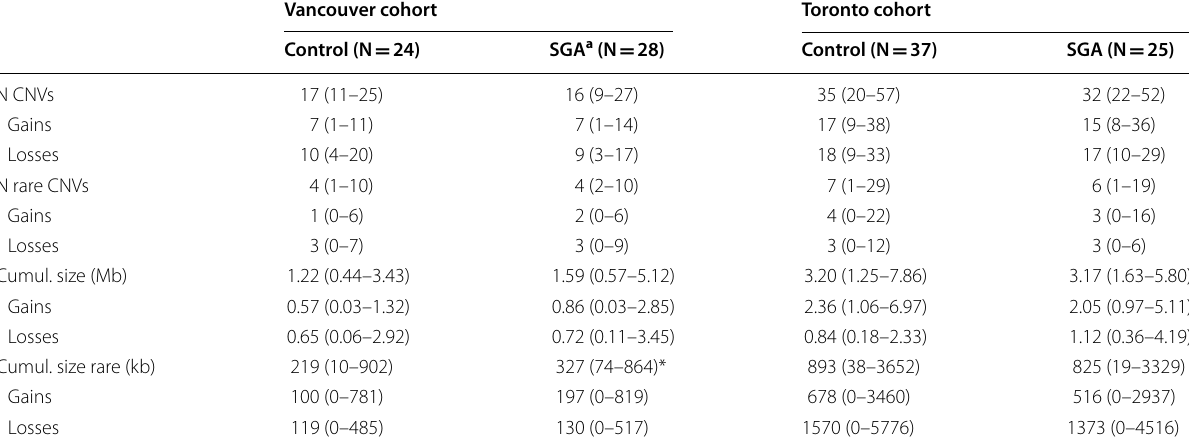
Cumul. cumulative